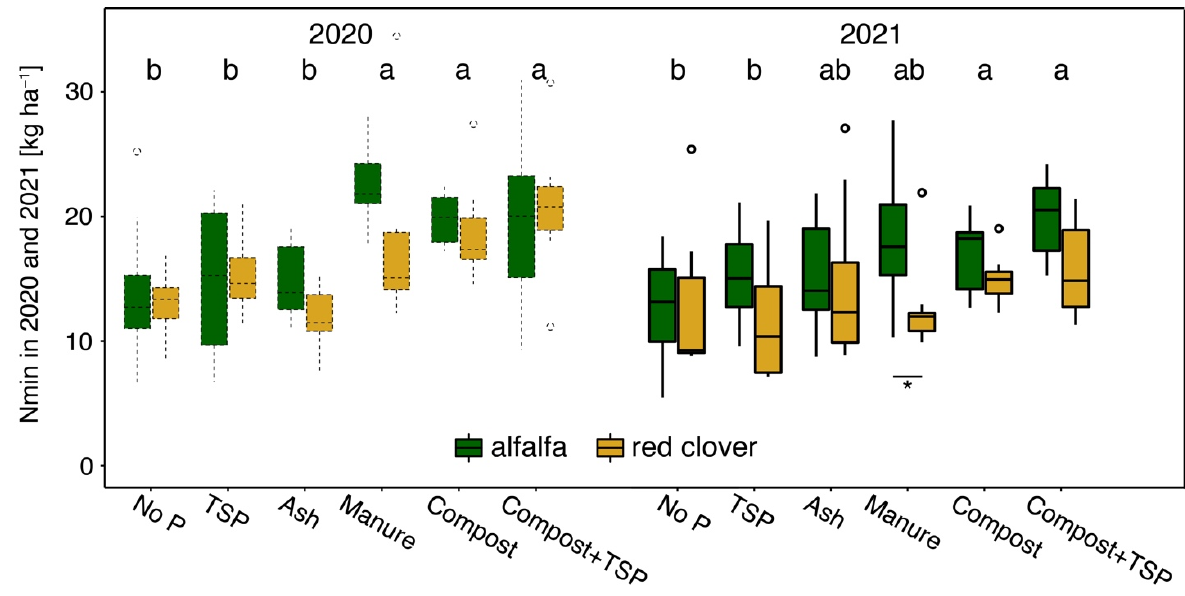
Figure 6. Mineral nitrogen (Nmin) content in the topsoil (0 to 30 cm) of the six studied treatments (no P, TSP, ash, manure, compost, and compost + TSP) with cultivation of alfalfa (green) and red clover (brown) in 2020 (framed with dotted lines) and 2021 (framed with solid lines). Letters indicate a significant difference between treatments (based on average of plant species) within the same year (Duncan’s new multiple range test with p < 0.05). Whiskers and asterisks indicate a significant interspecific difference between the respective treatments. Mean ± standard deviation (n = 8).